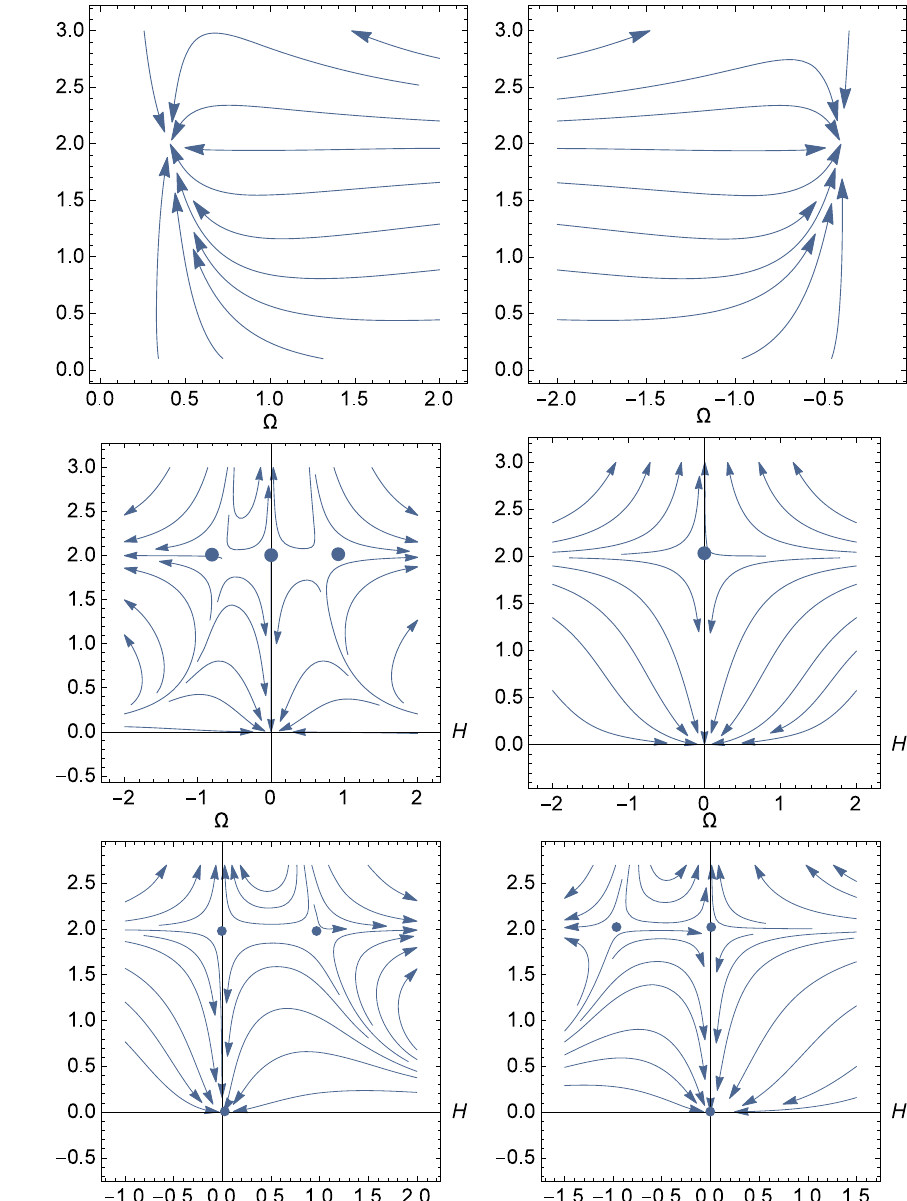
Fig. 9 Phase portrait of the system (2.25)–(2.26) for √ λ = 3 / 2 and γ = − 1 / 6 and √ γ = 1 / 6. In each case there are three equilibrium points at ( 0 , 0 ) , at ( 0 , 2 ) and at